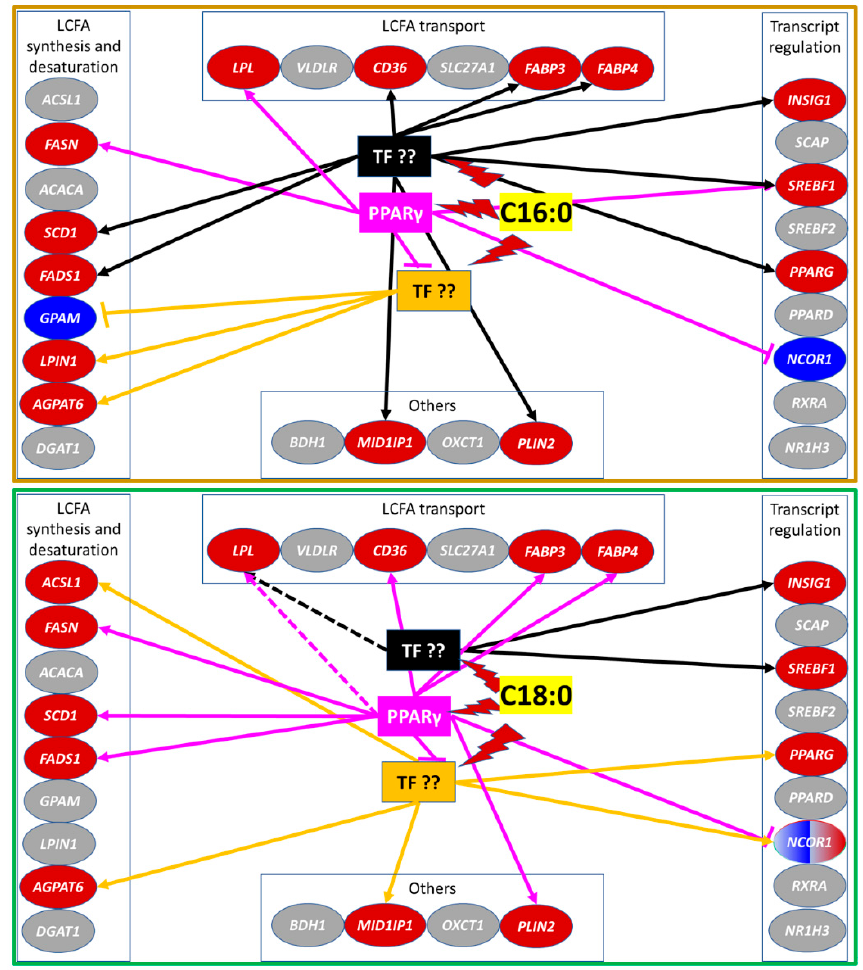
Figure 5. Schematic summary of the results from the present experiment for the response of transcription of various genes to saturated LCFA C16:0 and C18:0 clustered in functional groups related to milk fat synthesis. It is also reported the possible interaction of LCFA with PPAR γ or other unidentified transcription factors (TF) to elicit the observed responses. Grey shade denotes no significant change, red shade denotes upregulation, and blue shade denotes downregulation relative to control. In connecting lines, arrow head denotes induction while flat head denotes inhibition. Lightning symbol denotes induction of TF by the LCFA. Based on the results from our experiment, C16:0 controlled the expression of 4 genes ( SREBF1 , FASN , LPL , and NCOR1 ) via PPAR γ or partly via this transcription factor (TF) (as was the case for SREBF1 ). The expression of other genes was controlled via other TFs. Data indicated that the activity of C16:0 was via one or more TF (in black) controlling the expression of the majority of the genes a ff ected by C16:0 in our experiment that were independent from PPAR γ (including SREBF1 , which expression was only downregulated by the inhibition of PPAR γ but was still strongly upregulated compared to control). Expression of several genes, such as GPAM , LPIN1 , and AGPAT6 , was controlled by C16:0 via a TF which activity was somewhat inhibited by the activity of PPAR γ (in orange). C18:0 controlled the expression of 9 genes via PPAR γ , including LPL which e ff ect is only numerical and only partly via this TF. The expression of other genes was controlled via other TFs. Data indicated that the activity of C18:0 was via one or more TF (in black) independent from PPAR γ controlling the expression of only 2 measured genes ( INSIG1 and SREBF1 ). Expression of several genes ( ACSL1 , AGPAT6 , MID1IP1 , PPARG , and NCOR1 ) was upregulated by C18:0 via a TF which activity was inhibited by the activity of PPAR γ (in